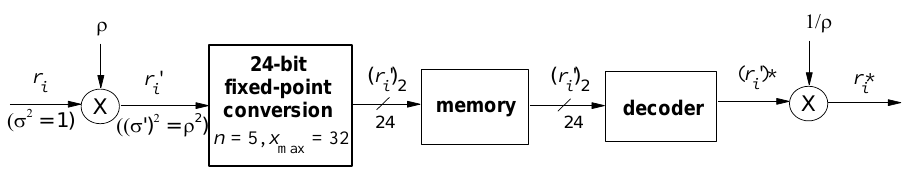
Figure 2. Conversion to the 24-bit fixed-point format with the Adaptation_1.